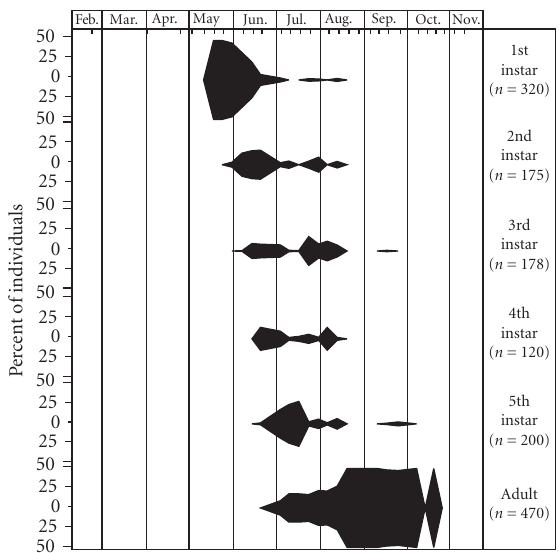
Figure 1: Percent of individuals of Metrobates hesperius in each stage on each sample date.